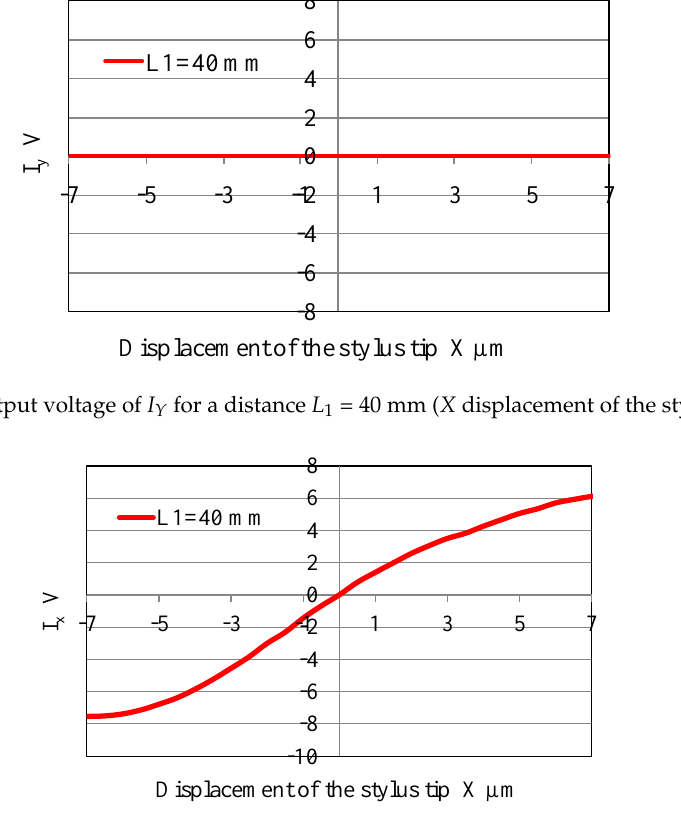
Figure 10. Output voltage of I X for a distance L 1 = 40 mm ( X displacement of the stylus tip).